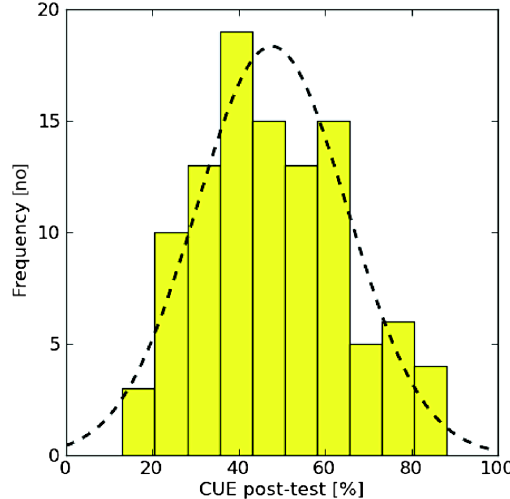
FIG. 5 (color online). Histogram of student scores on the CUE based on N ¼ 103 students in three courses.